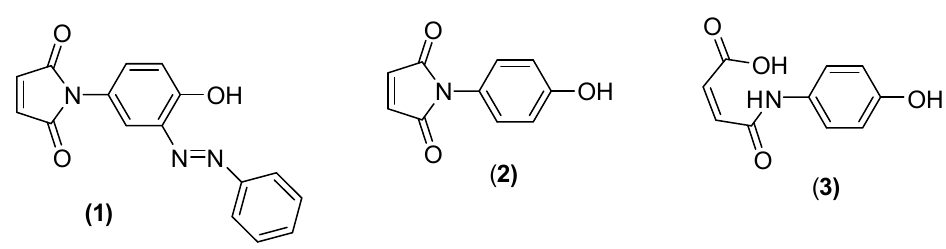
Figure 1. Structures of the desired product ( 1 ) and the two components of the mixture ( 2 ) and ( 3 ) now believed to be actual product of the reported synthesis.